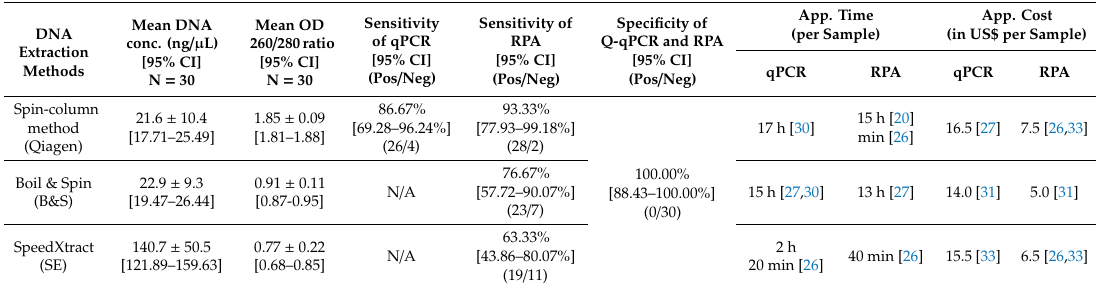
Table 2. Analysis of the performance of three DNA extraction methods with qPCR and recombinase polymerase amplification (RPA) assay.